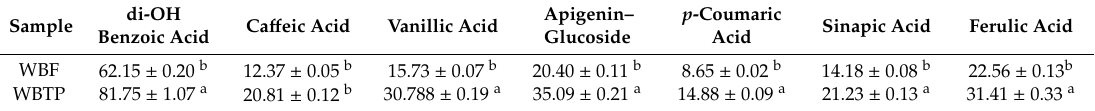
Table 3. Phenolic compound analysis of the fresh and thermally processed oat bran samples.